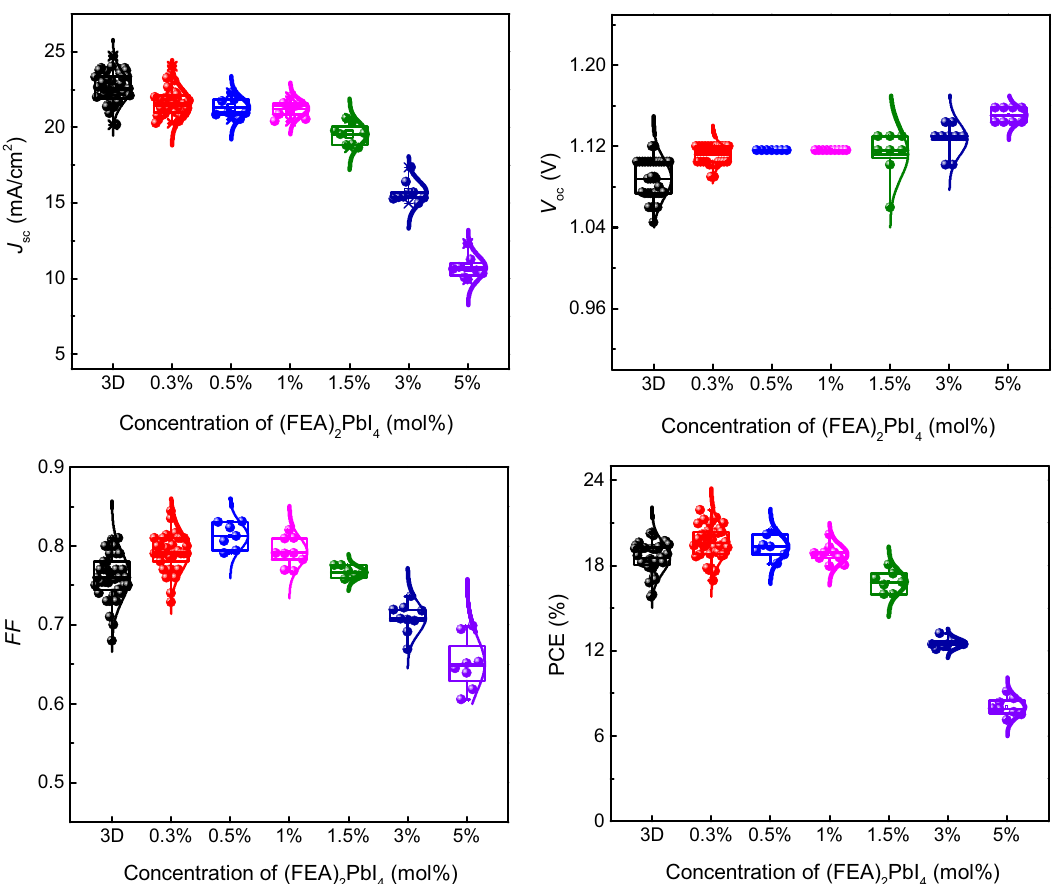
Fig. 1 J sc , V oc , FF, and PCE distributions for devices comprising MAPbI 3 and active layers with different mol% of (FEA) 2 PbI 4 . The box is de fi ned by two lines at the 25th percentile and 75th percentile with the line inside the box representing the median (the 50th percentile). The error bars indicate the 5th and 95th percentiles, and the curve overlay represents a normal distribution. At least eight PSCs for each type were tested. Although the MAPbI 3 devices had on average the highest short-circuit current density ( J sc ), addition of a small mol% of (FEA) 2 PbI 4 to the processing solution led to an increase in the open circuit voltage ( V oc ) and fi ll factor (FF), with an overall increase in the PCE. Although a larger mol% of (FEA) 2 PbI 4 in the active layer led to a larger V fi ciency (PCE), oc , all the other parameters, and hence the power conversion ef